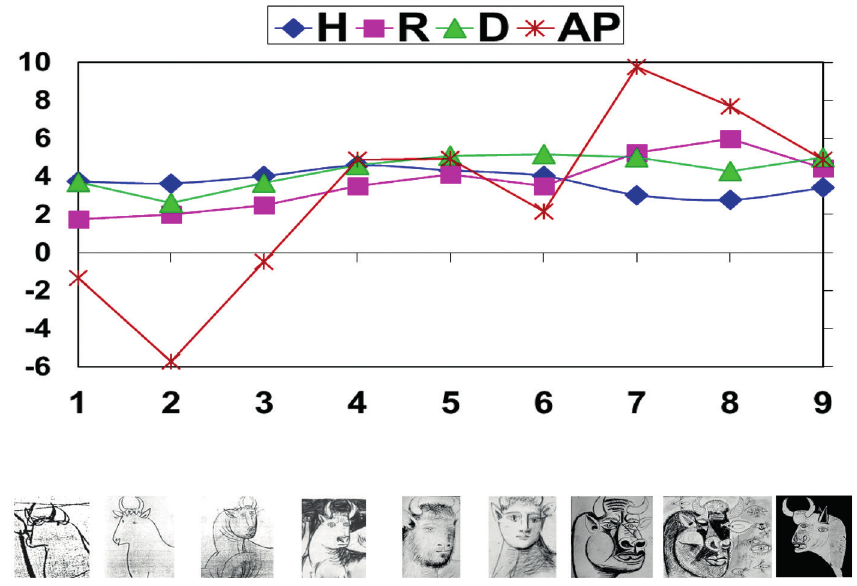
Grafikon 1. Dimenzije Sklada (H), Ukrašenosti (R), Distantnosti (D) i Arousal Potencijala (AP) tokom devet faza detalja glave bike u nastajanju Gernike (Milićević: